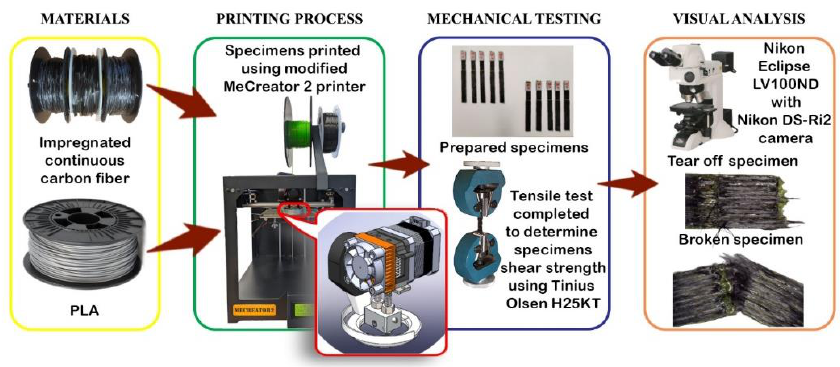
Figure 1. Research methodology .